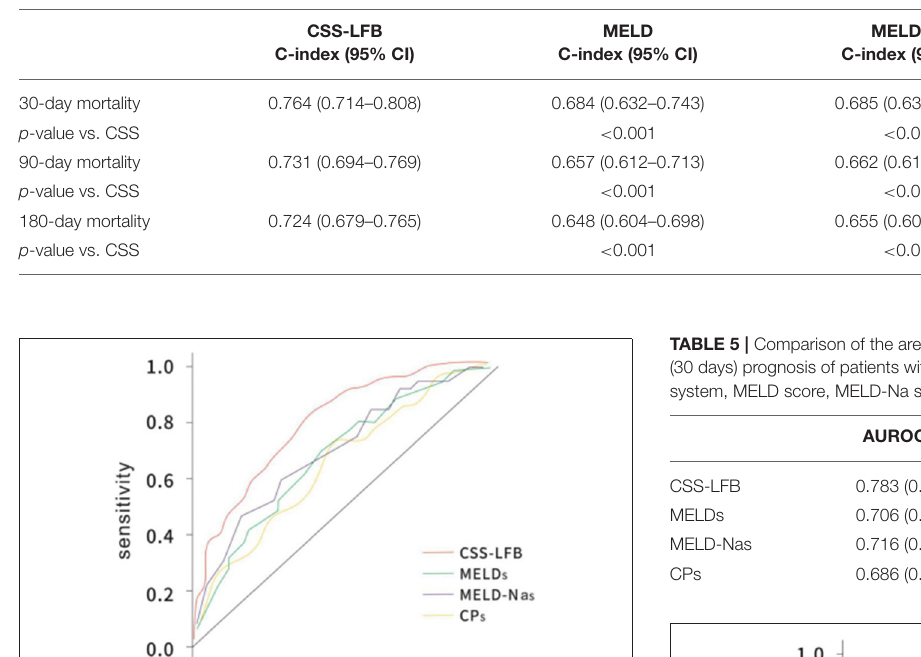
TABLE 4 | The ability to predict and differentiate disease outcomes at different times with different scoring systems.